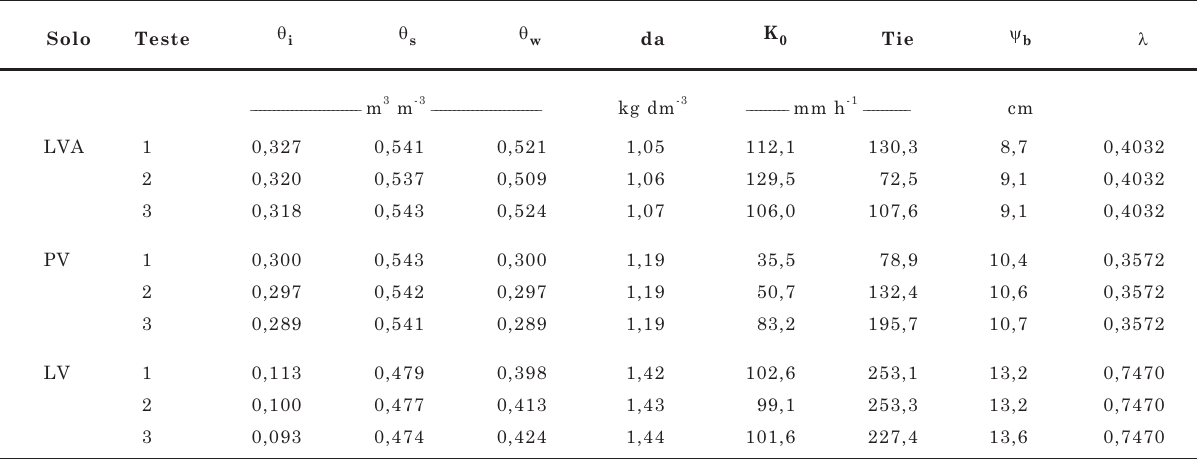
Quadro 2. Atributos físicos dos solos